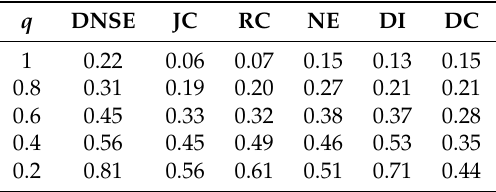
Figure 5. Detection rate and γ %-accuracy of DNSE( k ) for various diffusion parameter q . (we set the flipping parameter p = 0.3 and dynamic parameter k = 5000.) ( a ) Detection rate vs. Budget B . ( b ) γ %-accuracy. Table 4. Detection probability of DNSE( k ) compared to other methods by varying q . We use the dynamic parameter p = 0.3 and investigation budget B =